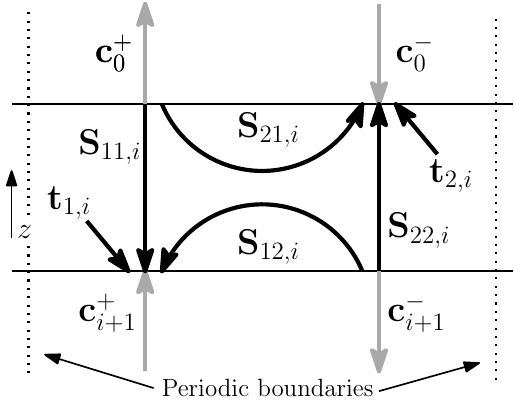
Figure 1. Visual representation of the scattering formulation for a single